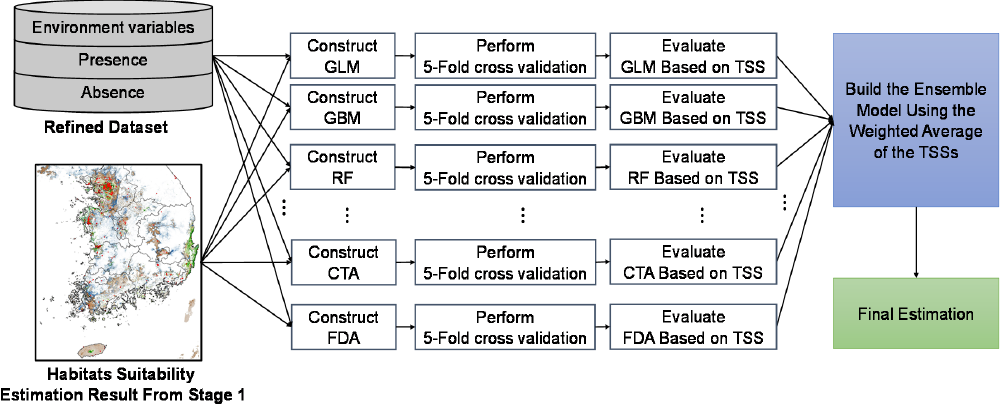
Figure 4. Construction of the ensemble model employed in Stage 2 of the present study.